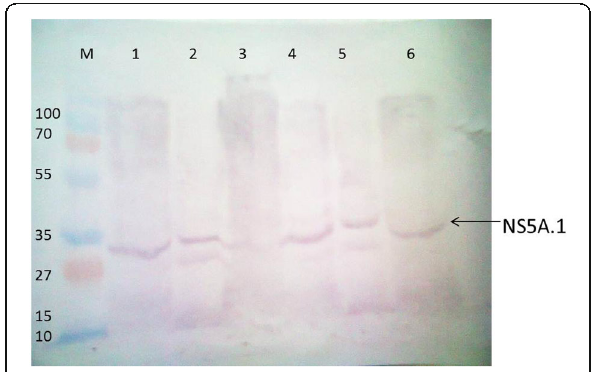
Fig. 10 NS5A.1 antigenic site protein expressed in bacterial cells (vector specific). Lanes 1, 2, 4, and 6: NS5A.1 antigenic protein; M: prestained protein